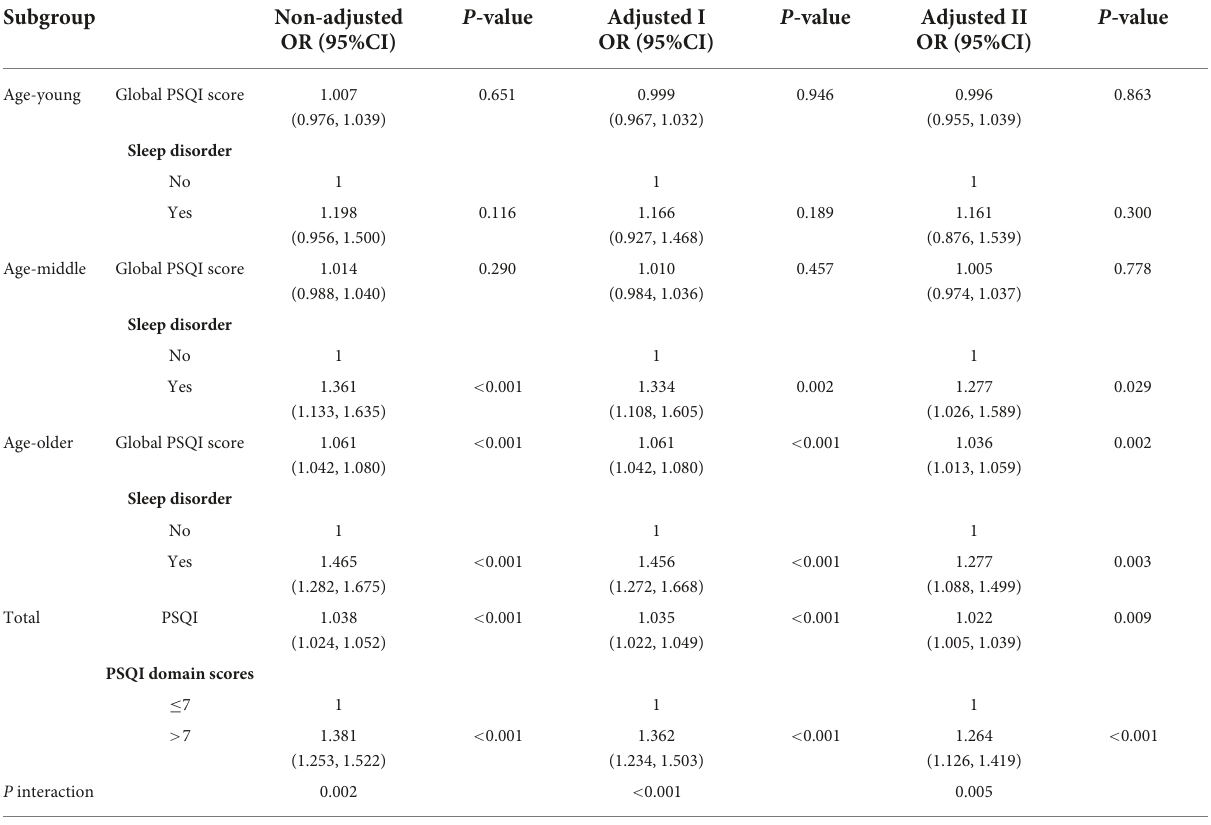
TABLE 4 Stratified multiple logistic regression analysis to identify variables that modify the correlation between sleep quality and LUTS/BPH. Subgroup